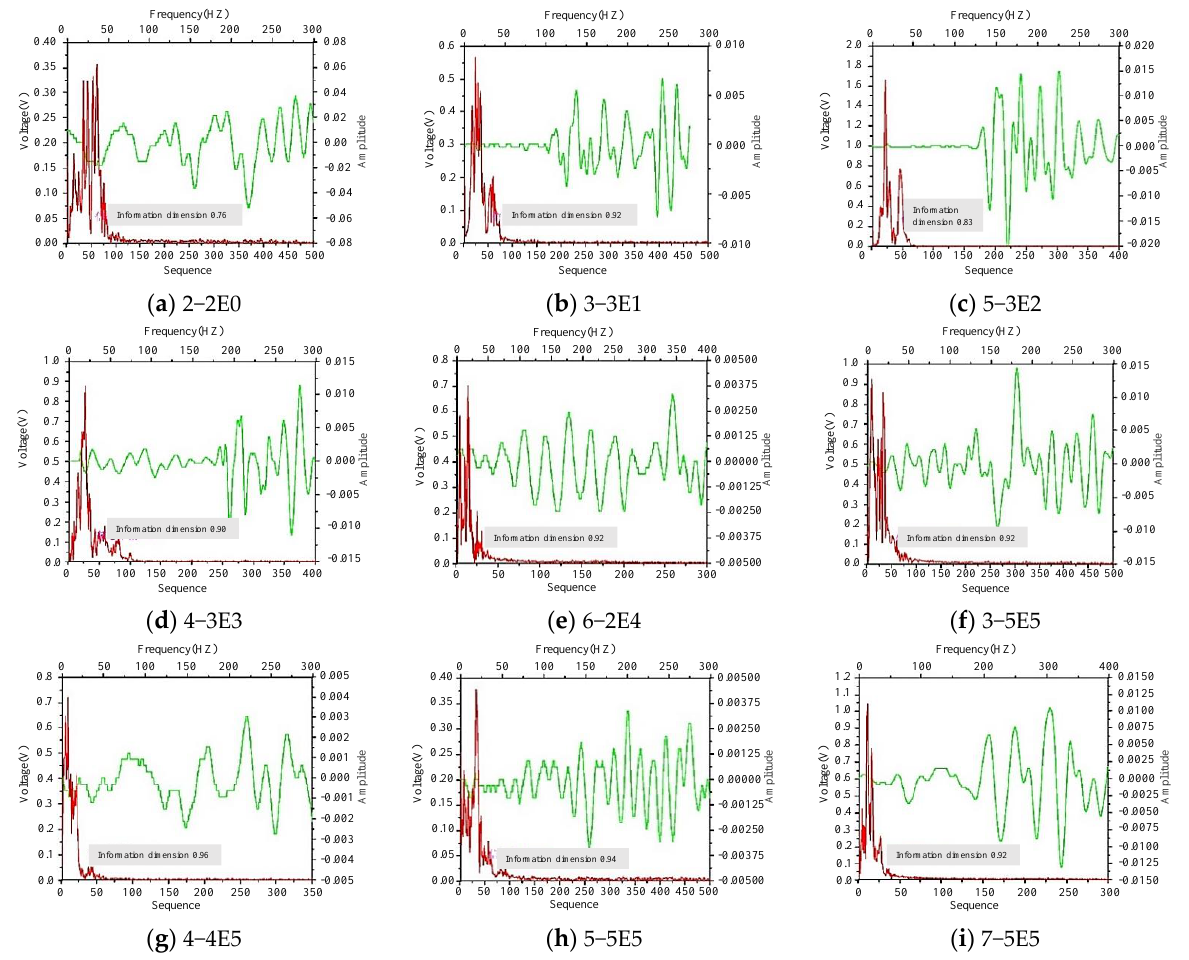
Figure 24. Acoustic emission event signal characteristics.